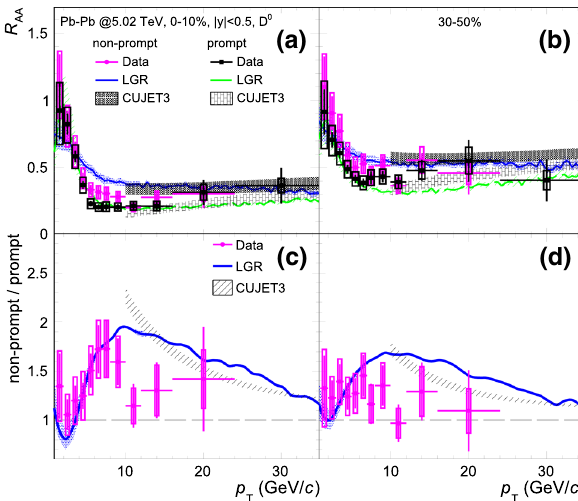
Fig. 5 Upper: comparison of non-prompt (solid blue curve) and prompt D 0 (dashed green curve) R AA calculations as a function of p T with the CUJET3 [50–52] (filled black regions) and the measured values (pink circle [53] and black square points [54]), in the cen- tral 0 − 10% (a) and semi-central 30 − 50% (c) Pb–Pb collisions at √ s NN = 5 . 02 TeV; Bottom: further comparison of D 0 R AA between non-prompt and prompt components. See legend and text for details